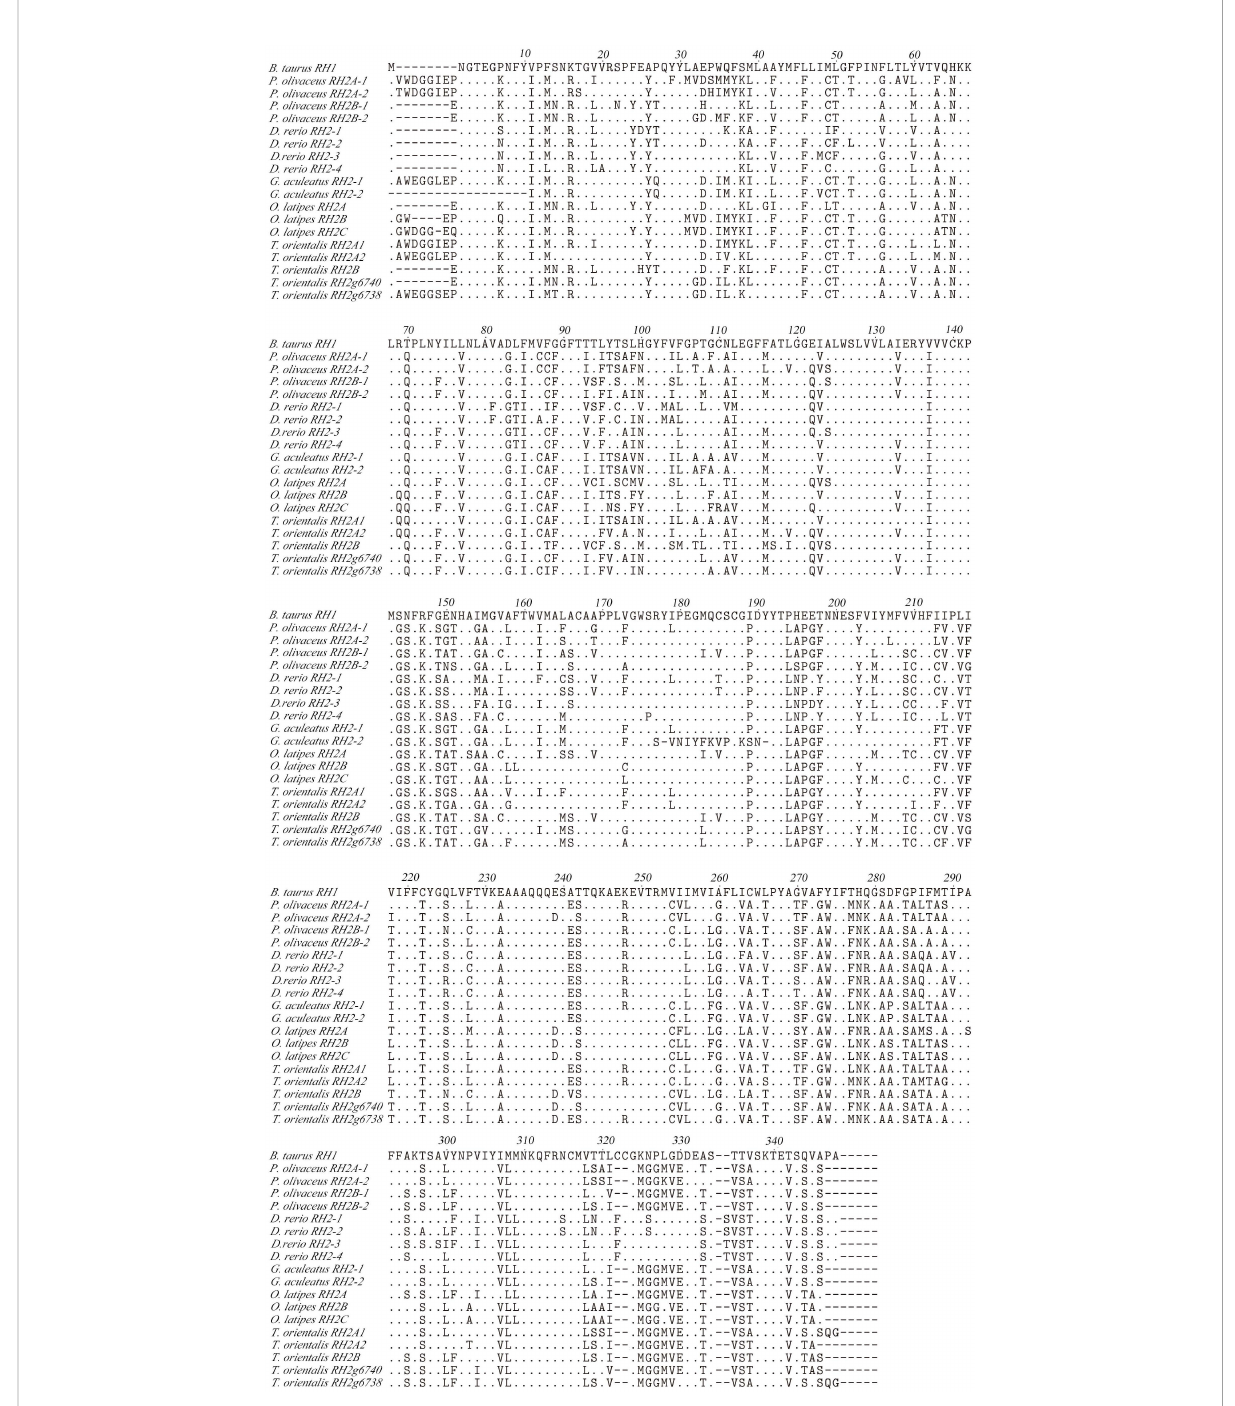
FIGURE 2 Amino acids alignment of RH2. The dots represented the same amino acid sites compared with B . taurus RH1 sequence among different species. The horizontal lines represented the missing of amino acid sites compared with each other.